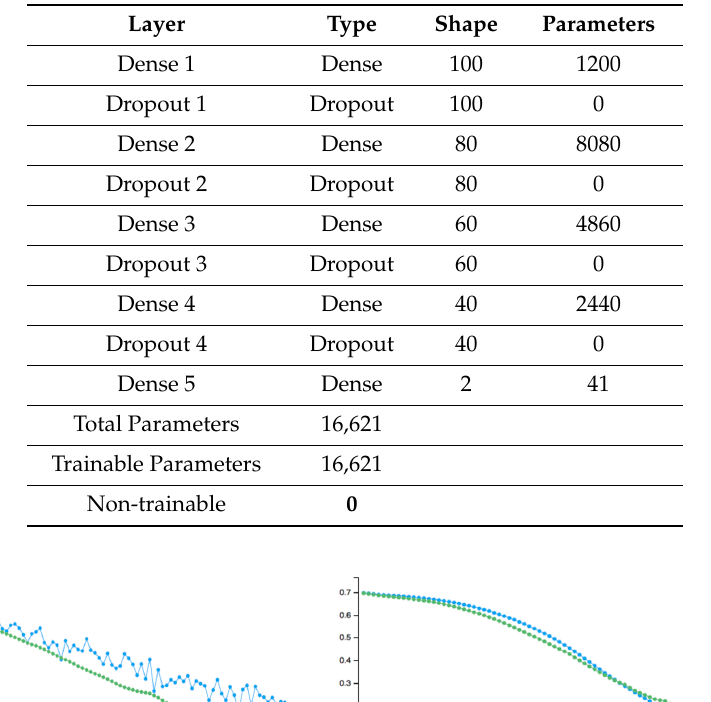
Table 2. Parameters training using Dense and Dropout layers based on TensorFlow with Keras.